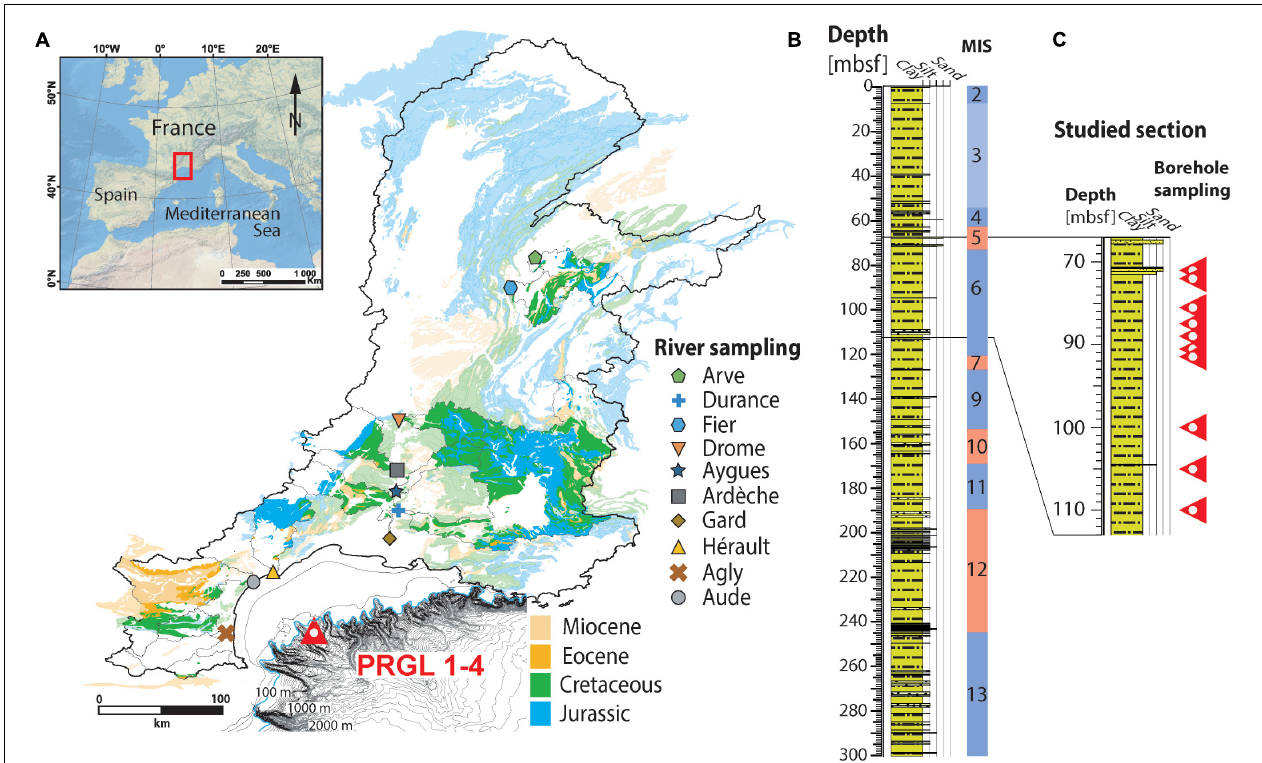
FIGURE 1 | (A) Map of the Gulf of Lion and its watershed with the location of the PRGL1-4 core (42.690N; 3.838E), and riverbed samples. Distribution of stratigraphic units containing carbonate rocks in the catchment are color-coded by age of deposition. (B) Composite lithological and sedimentological log of PRGL 1-4, and associated climatic context where pink and blue bands corresponds to interglacial and glacial periods (dark and light blue bands represent sensu-stricto and sensu-lato , respectively). MIS refers to Marine Isotopic Stage according to Railsback et al., 2015. (C) Close up view of the studied section with samples